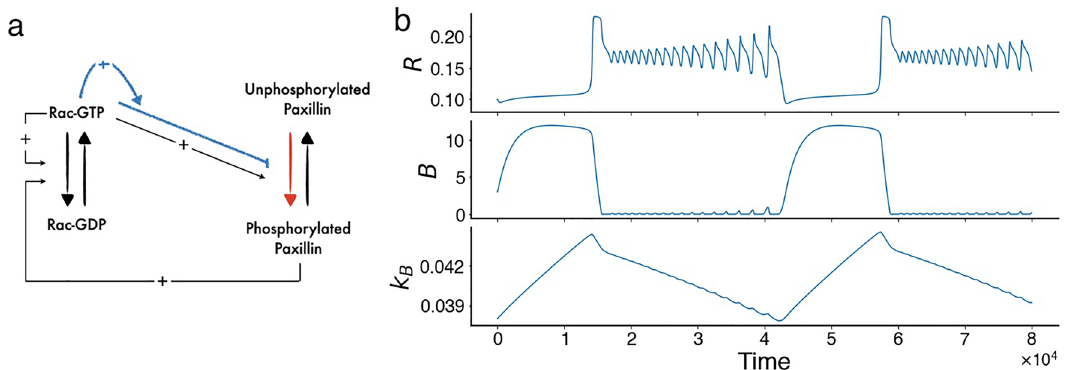
Figure 2. Model framework and model simulations. ( a ) Schematic of the semi-phenomenological four- variable (4V) model of Eqs. (3) in the absence of diffusion. Rac cycles between inactive (GDP-bound) and active (GTP-bound) forms. Rac-GTP (denoted by R ) exerts an indirect positive auto-feedback (via Rho) on itself through RacGEF. It also simultaneously exerts positive and negative (blue pathway) feedback on paxillin phosphorylation at a fast and a slow timescale, respectively. Phosphorylated paxillin, in turn, indirectly upregulates Rac activation through RacGEF. Blue pathway: refinement of the original model 21 ; red pathway: the reaction directly influenced by the half-maximum phosphorylation of paxillin ( L K ). ( b ) Time courses of active Rac ( R ), phosphorylation rate ( B ) and recovery rate ( k B ) in the absence of diffusion, showing the presence of mixed-model oscillations (MMOs) in R